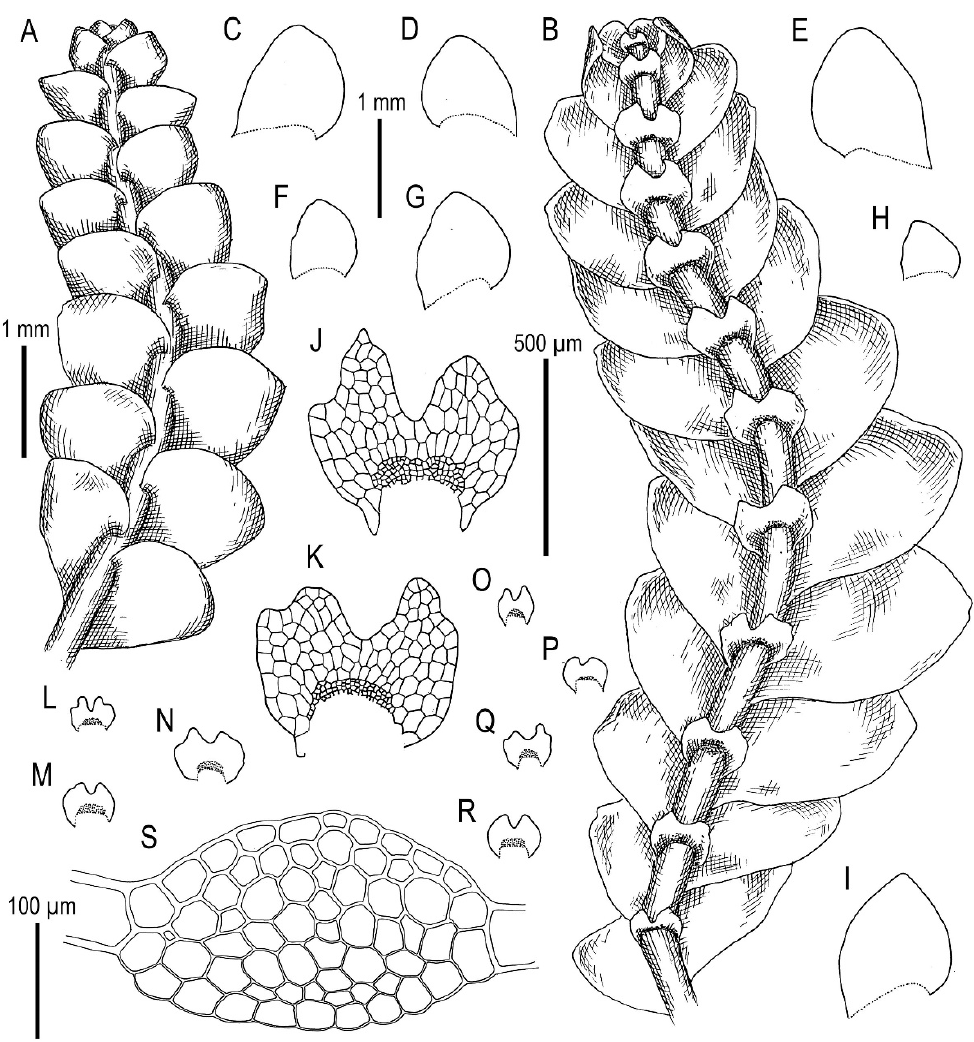
Figure 22. Calypogeia fissa (L.) Raddi: ( A ) Plant habit, fragment, dorsal view; ( B ) Plant habit, fragment, ventral view; ( C – I ) Leaves; ( J – R ) Underleaves; ( S ) Stem cross section. All from G-12-55-13 (VBGI). Calypogeia shevockii Bakalin et Troizk., sp. nov.